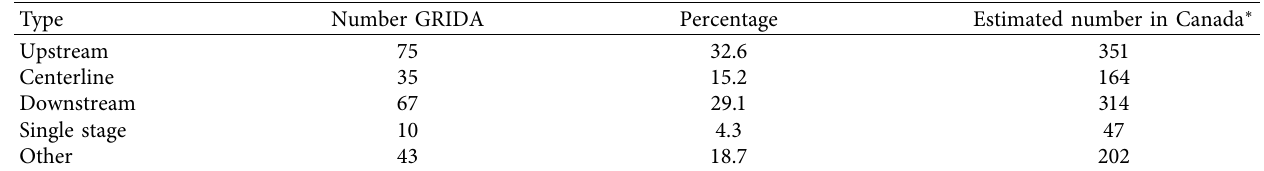
Table 4: Estimation of Canada tailings number by